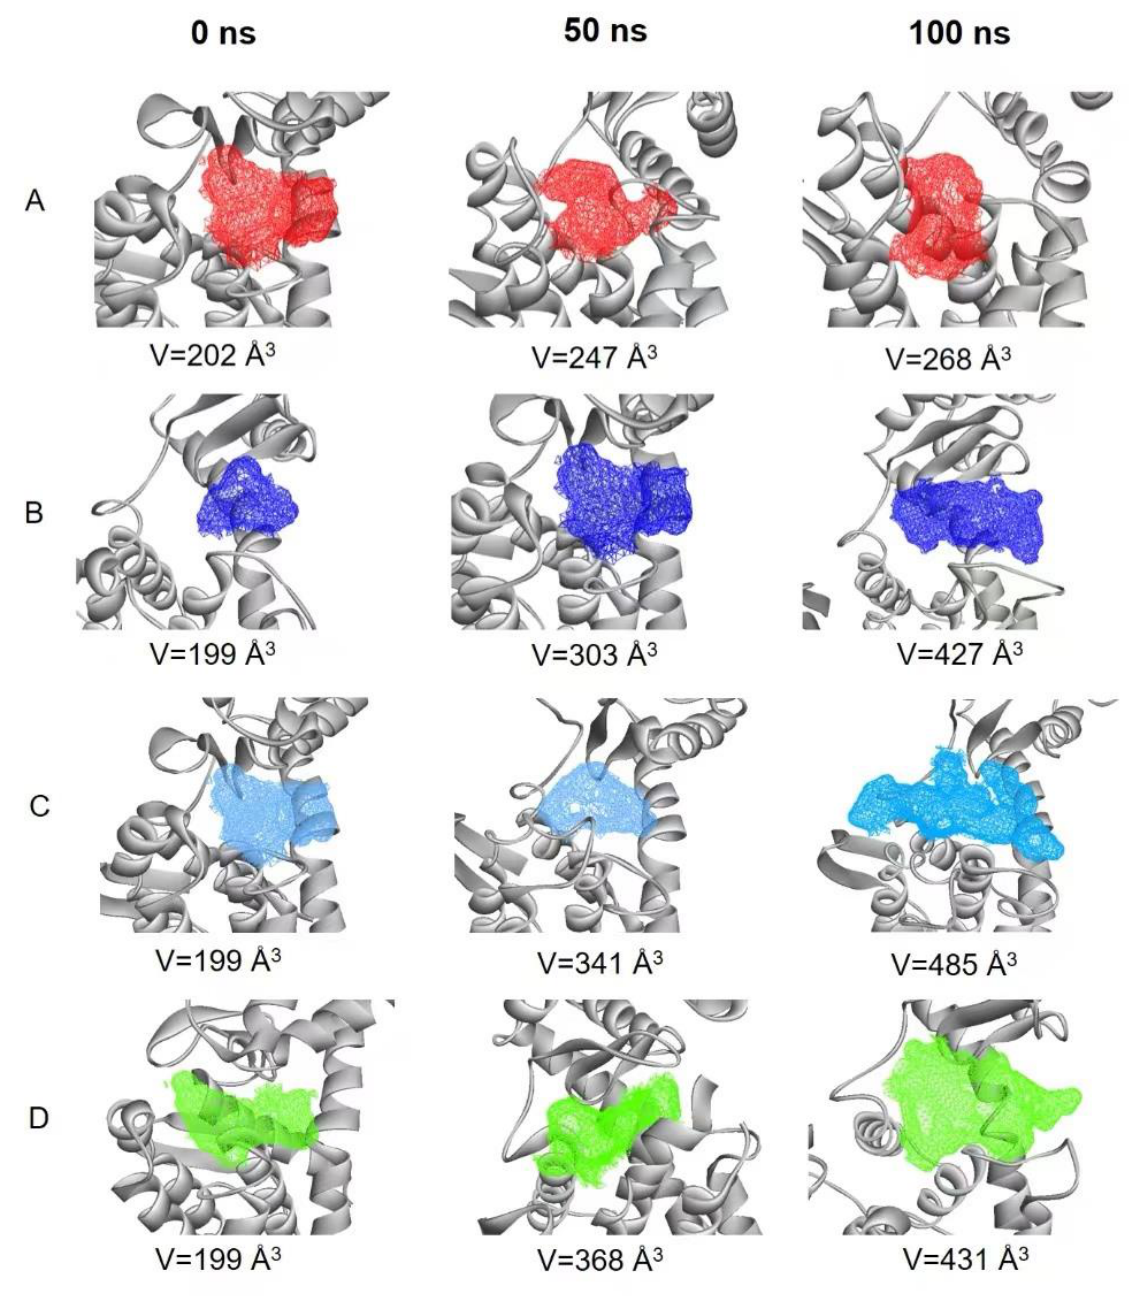
Figure 9. Size and shape of active pockets at 0, 50 and 100 ns in: ( A ) free 7C6C (red); ( B ) 7C6C-(GlcN) 2 (dark blue); ( C ) G21K-(GlcN) 2 (light blue); ( D ) G21R-(GlcN) 2 (green).